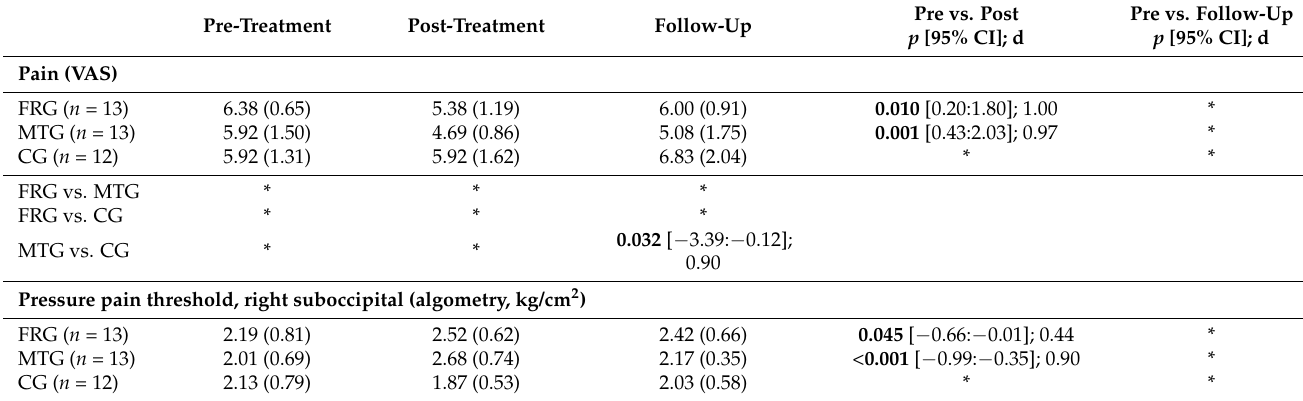
Table 4. Results of the multiple comparisons for the analyzed